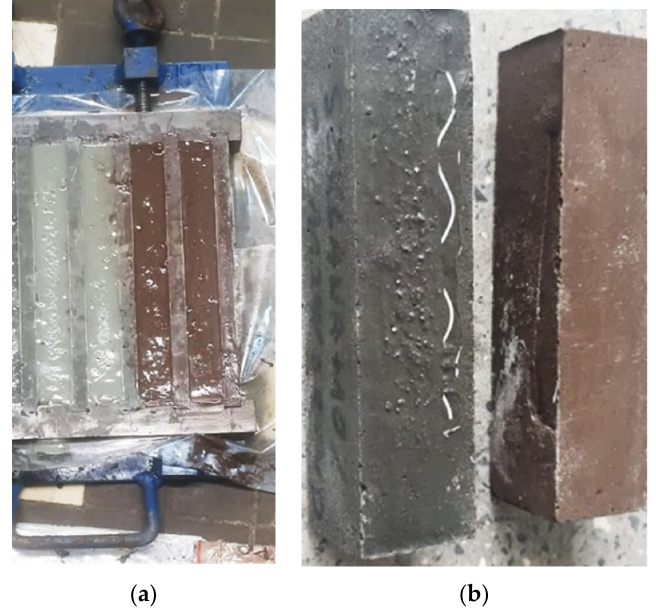
Figure 4. Geopolymer binder ( a ) mortar ( b ) with rock wool with bauxite (top sample) and with Al 2 O 3 (downsample).